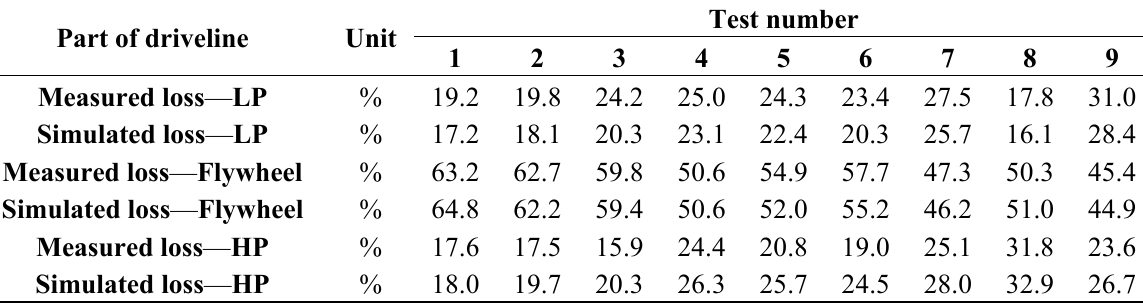
Table 10. Comparison of measured and calculated distribution of losses in the